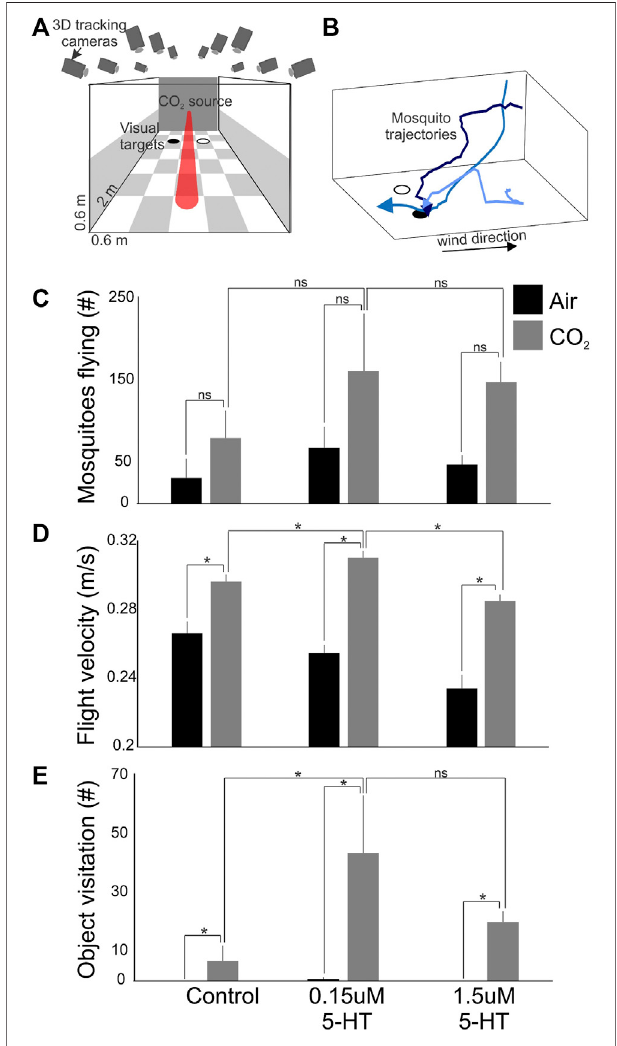
FIGURE 2 | Flight activity and response to visual objects of A. stephensi following 5-HT provisioning in a bloodmeal. (A) Wind tunnel and associated computer vision system for real-time tracking of mosquito behaviors. (B) Example mosquito trajectories. After encountering the CO 2 plume, mosquitoes increase their fl ight velocity and become sensitized to visual objects, like a black circle. (C) The numbers of mosquitoes fl ying in the wind tunnel during exposure to clean air (black histogram) and CO 2 (grey histograms) for different treatments (control, 0.15 µM 5-HT, and 1.5 µM 5- HT). (D) Same as in (C) , except for the fl ight velocities of the mosquito tracks. (E) Same as in (C) , except for the numbers of mosquitoes that investigated attractive visual objects on the fl oor of the wind tunnel. Bars are the mean ± sem; * p < 0.05; and ns > 0.05 (Kruskal-Wallis test with Tukey post hoc test).